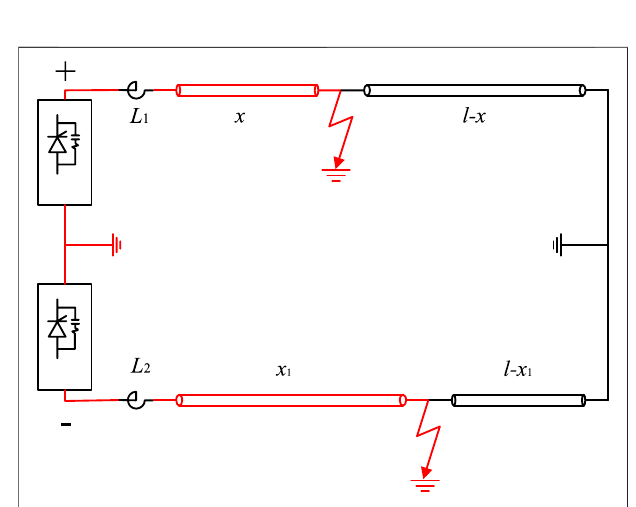
FIGURE 5 | Abnormal grounding at different bipolar positions.